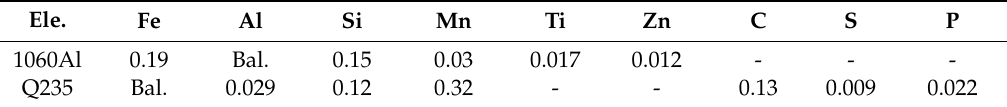
Table 1. Chemical compositions for 1060Al / Q235 composite plate (unit: wt.%). Ele. Fe Al Si Mn Ti Zn C S P 1060Al